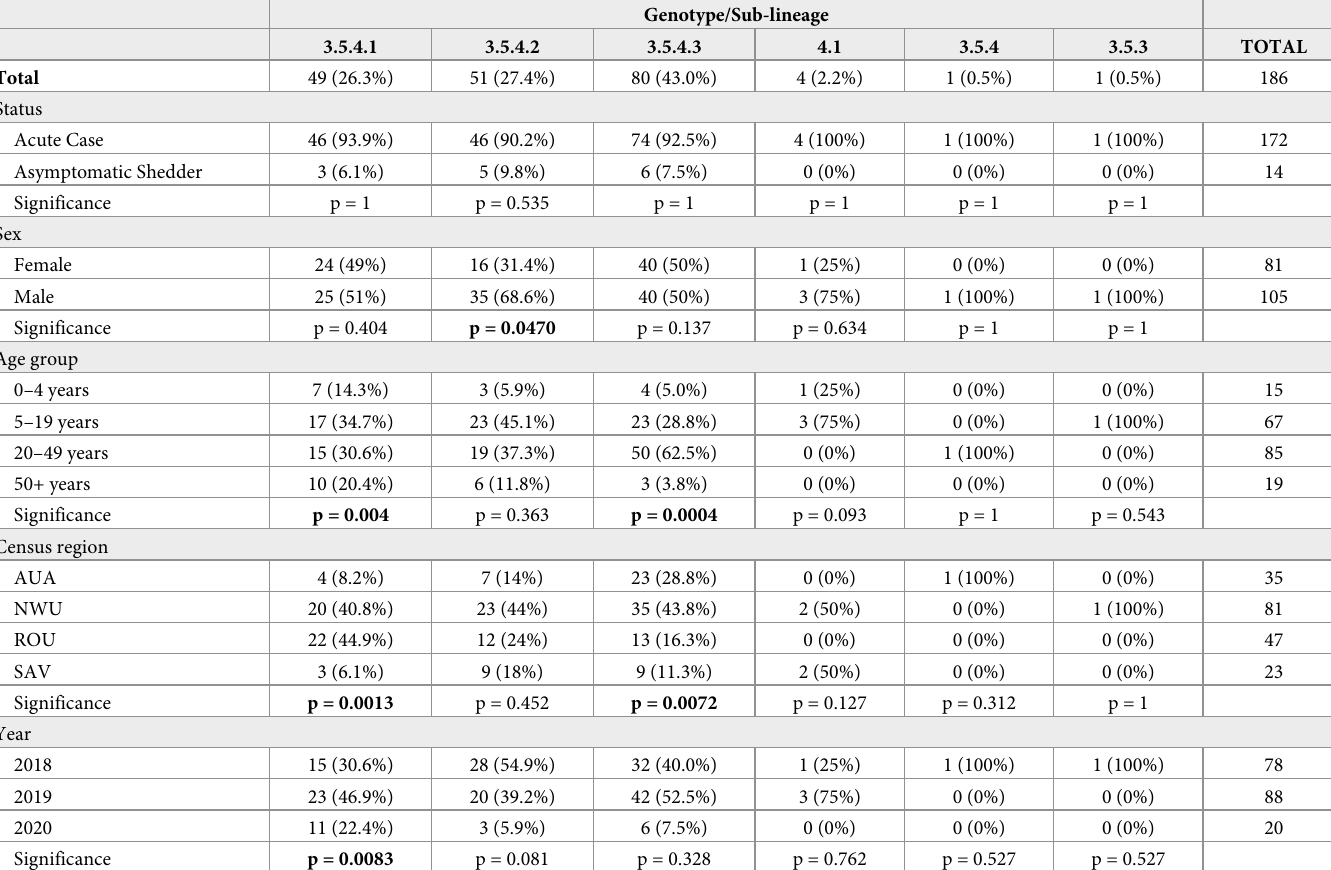
Table 3. Comparison of epidemiologic variables relating to person, place, and time for each Samoa dominant S . Typhi